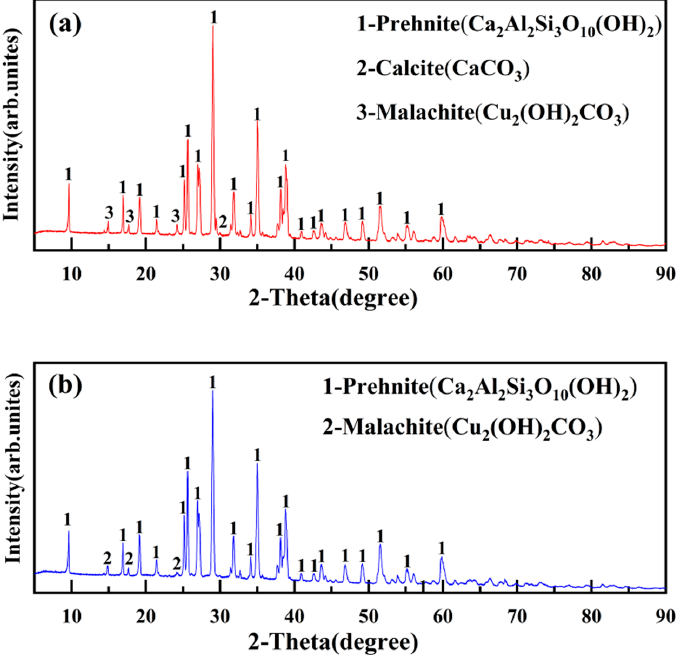
Figure 28. XRD pa tt erns of ore unearthed from the site of Yubeidi site. ( a ) XRD pa tt erns of YBD25; ( b ) XRD pa tt erns of YBD26.